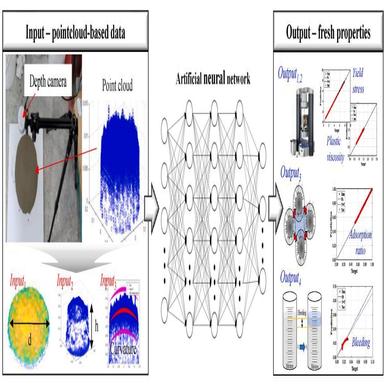
Schematic illustration of the ANN-based modeling for estimating fresh properties.